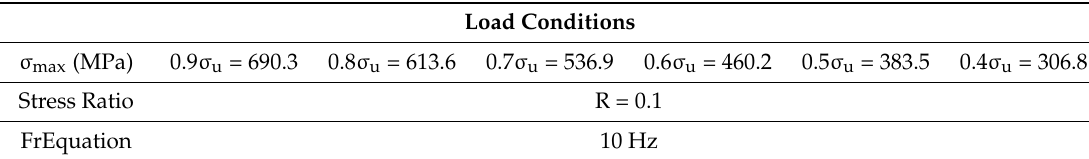
Figure 9. Configuration of test specimen (ASTM E8M, unit: mm). Table 4. Fatigue test conditions.